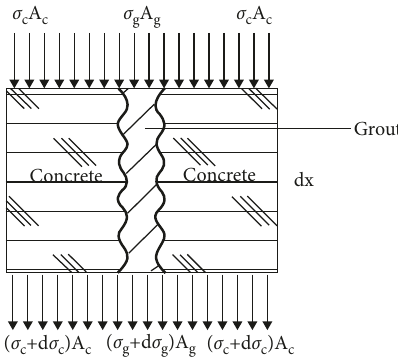
Figure 13: Structural analysis of differential